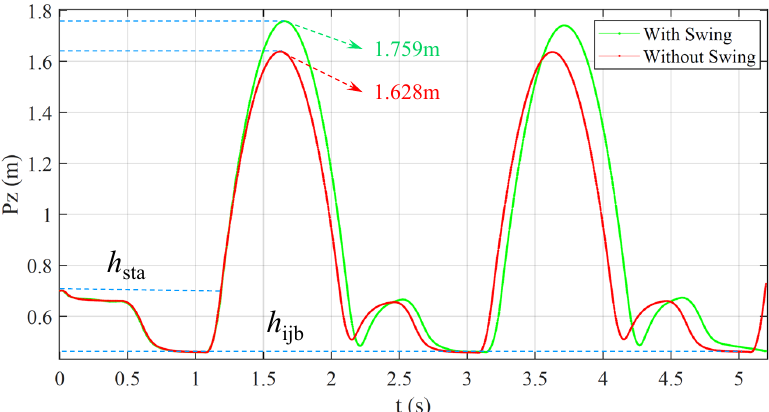
Figure 8. The height change curve of robot torso during jumping